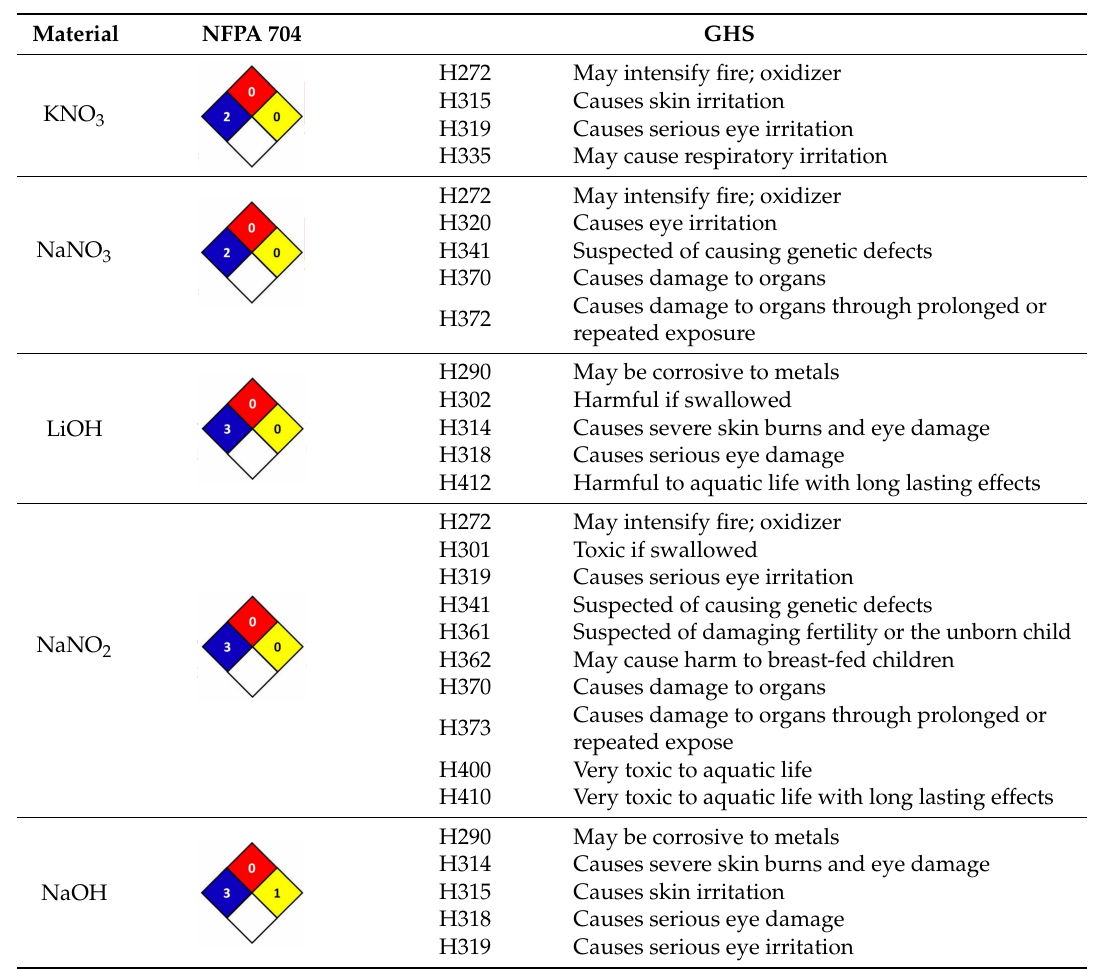
Table 5. Health hazard values according to NFPA 704 and Globally Harmonised System (GHS) of the considered inorganic materials